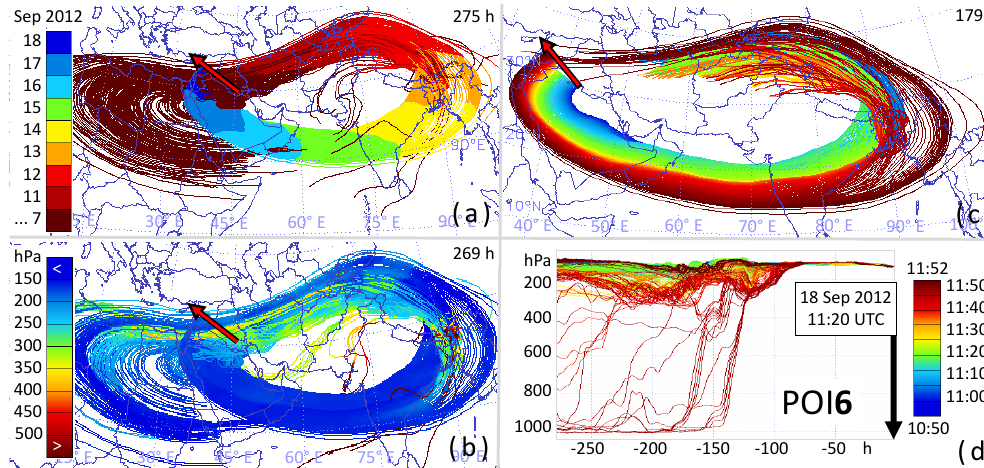
Figure A5. As Fig. 3, but for POI6. This flight segment is dominated by UT ASMA air.